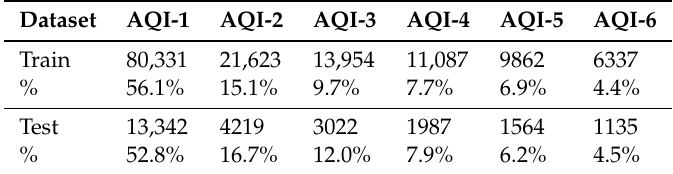
Table 2. Distribution of the dataset in 6 classes.